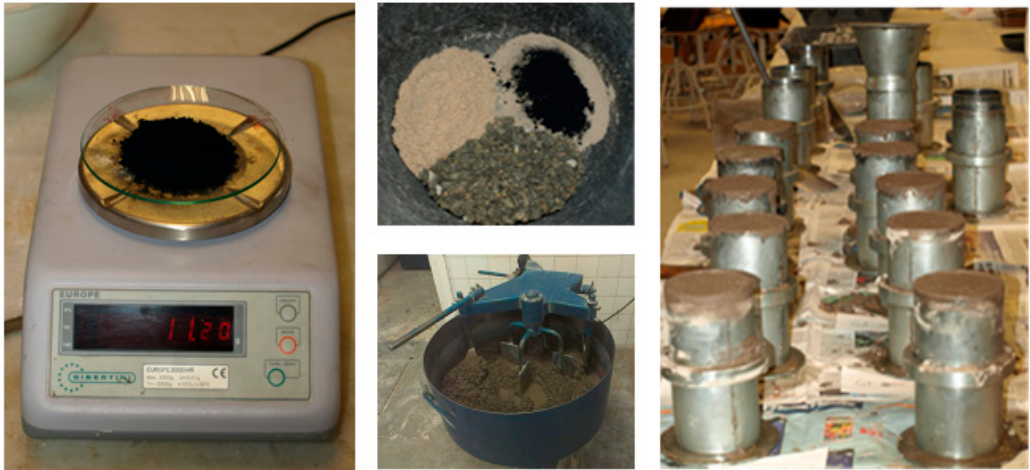
Figure 1. Process of manufacturing cylindrical test pieces with and without addition: dosage, standardization, mixing and molding.